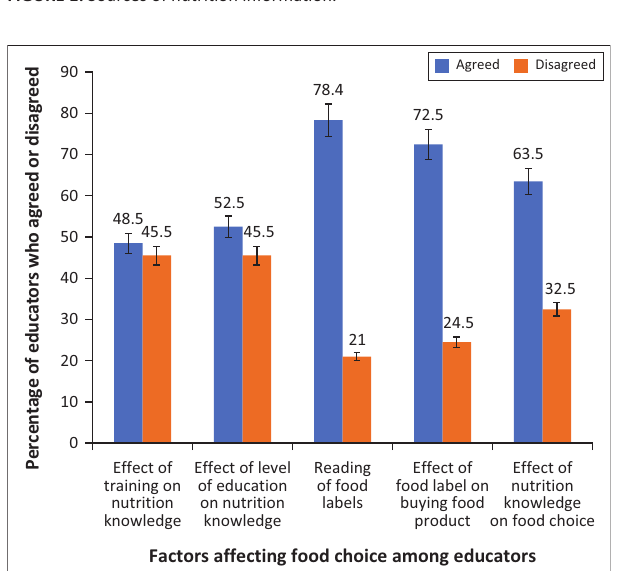
FIGURE 2: Factors affecting food choice among educators ( n = 200).